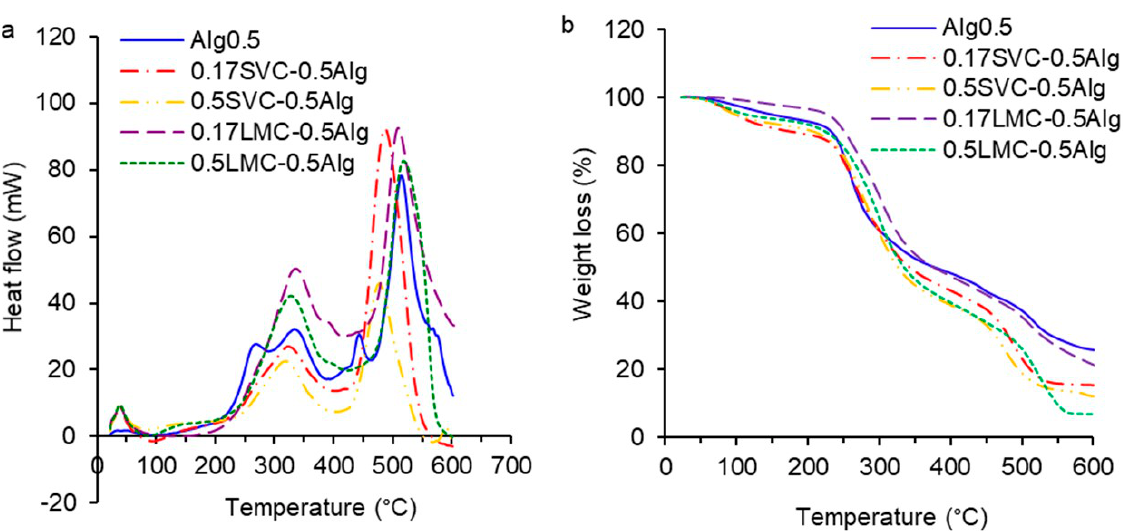
Figure 4. DSC ( a ) and TGA ( b ) thermograms of GSE-loaded Ca-alginate (Alg0.5) and Alg0.5/callus (0.17SVC-0.5Alg, 0.5SVC-0.5Alg, 0.17LMC-0.5Alg, 0.5LMC-0.5Alg) particles.